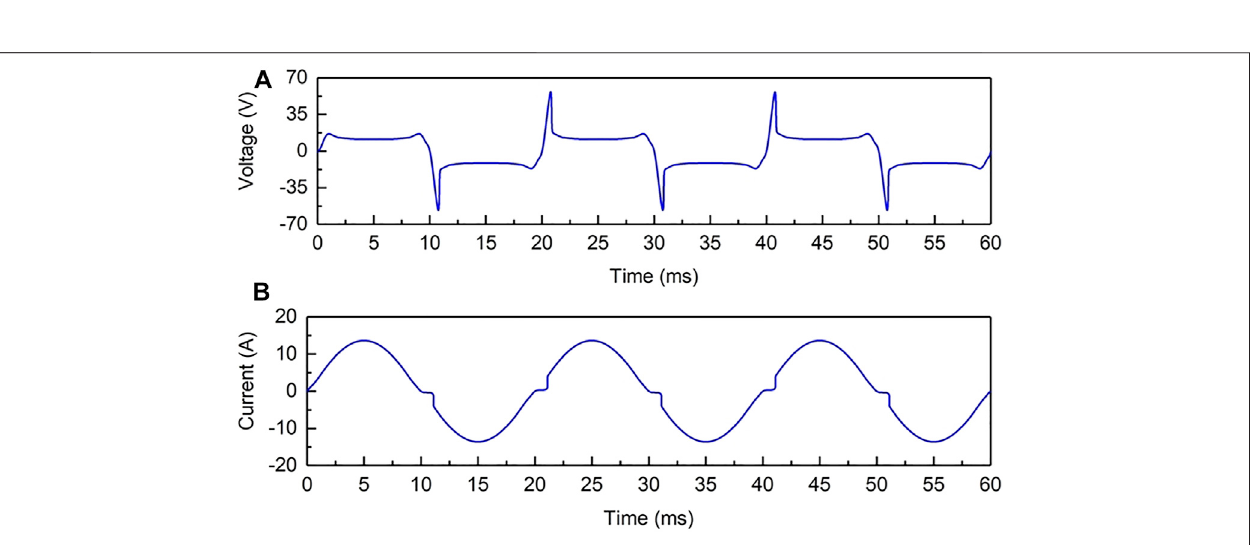
FIGURE 11 | Resistive load (A) voltage and (B)